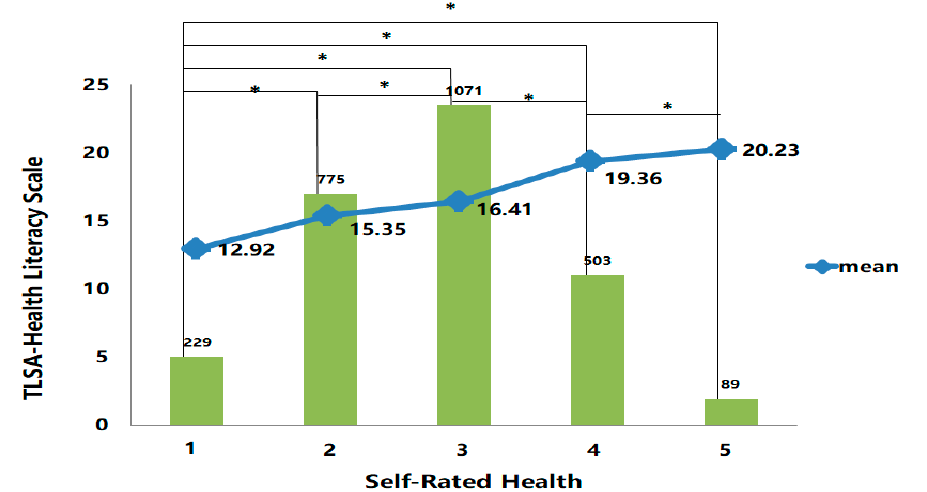
Figure 1. Mean TLSA Health Literacy scale vs. Self-Rated Health. Self-Rated Health: first-very good, n = 229; second group-good, n = 775; third group-fair, n = 1071; fourth group-bad, n = 503; fifth group-very bad, n = 89. TLSA health literacy scale increased with higher self-rated health status (higher scores were associated with worse self-rated health and health literacy). * p < 0.05 (Bonferroni corrected t -tests).